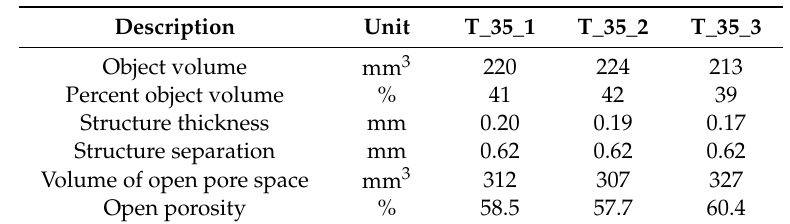
Table 6. Comparison of µ CT scan data of 3DP PVA_K / CL tablets with 35% of infill ratio.